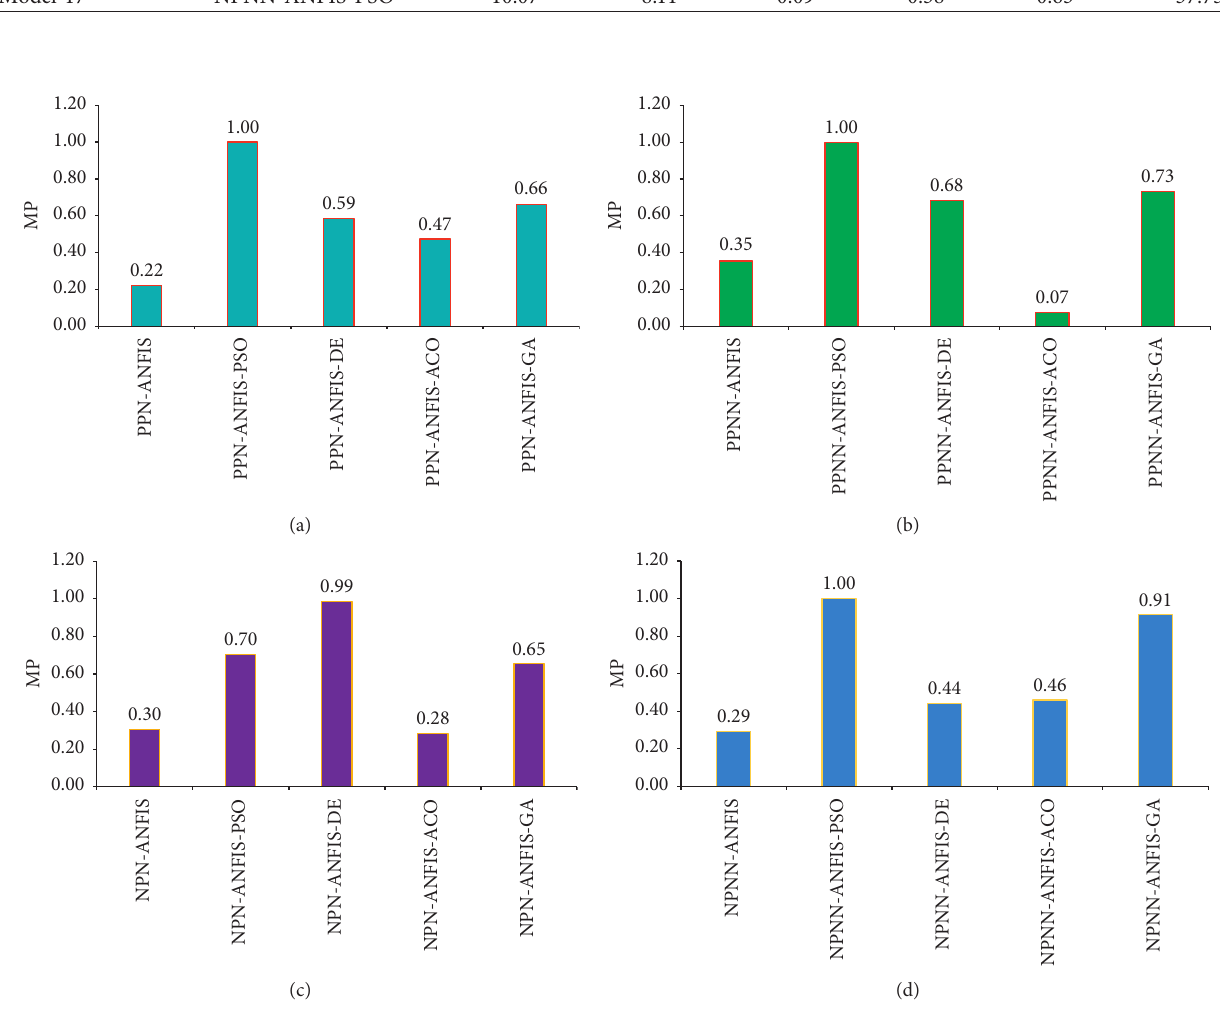
Figure 5: The mean performance index computed for the applied hybrid and classical ANFIS models over the test phase; (a) PPN scenario, (b) PPNN scenario, (c) NPN scenario, and (d) NPNN